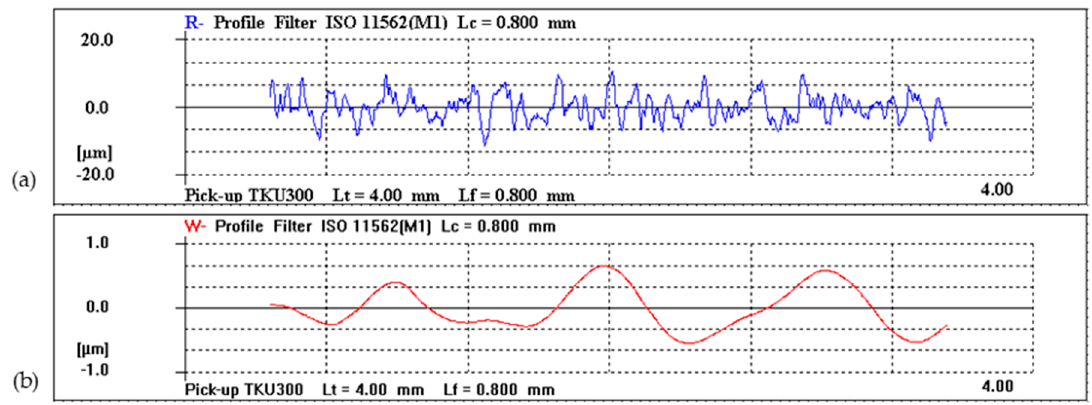
Figure 11. The surface roughness profile ( a ) and the surface waviness profile ( b ), as measured in perpendicular direction to the wire feed.